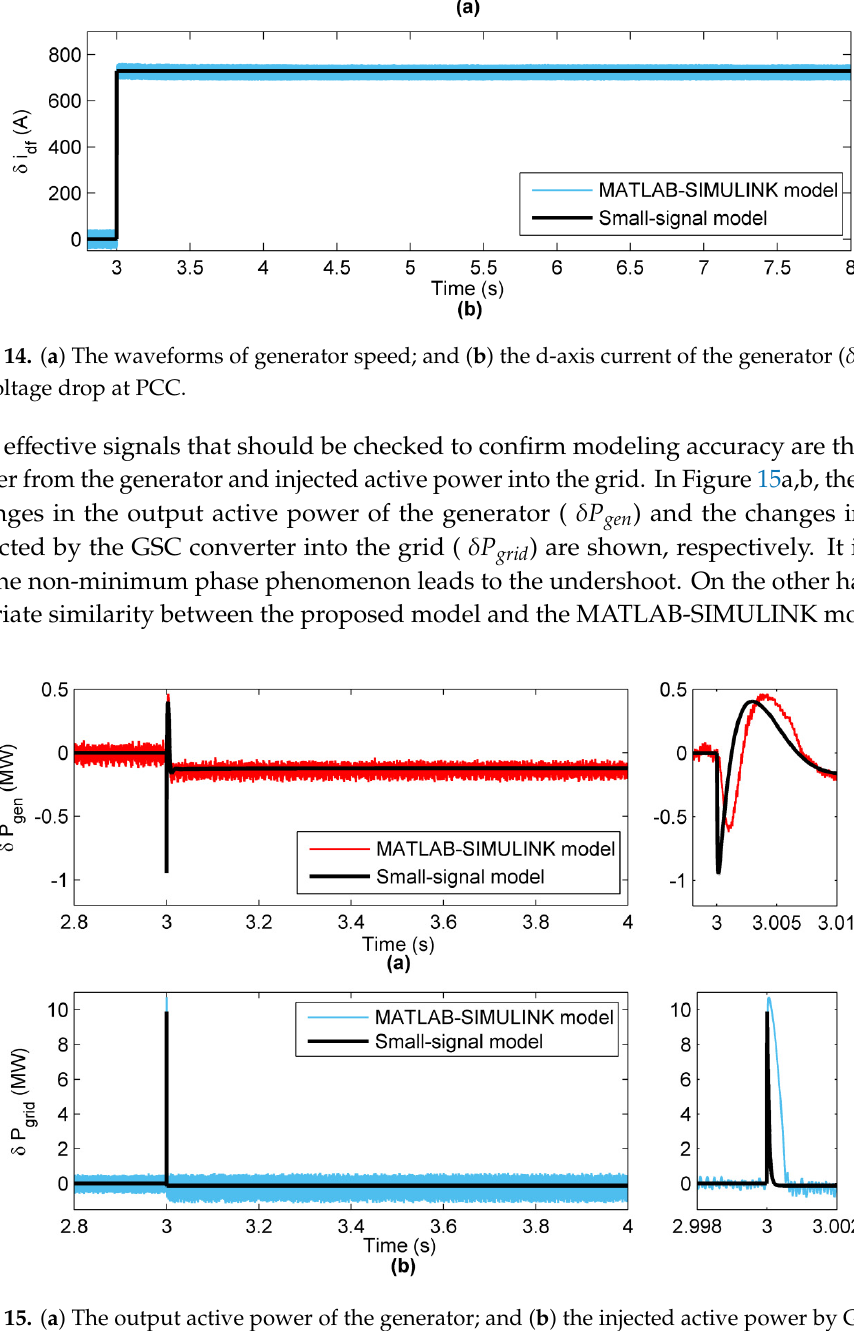
Figure 15. ( a ) The output active power of the generator; and ( b ) the injected active power by GSC into the grid ( grid P δ ) in a 50% voltage drop at PCC. the grid ( δ P grid ) in a 50% voltage drop at